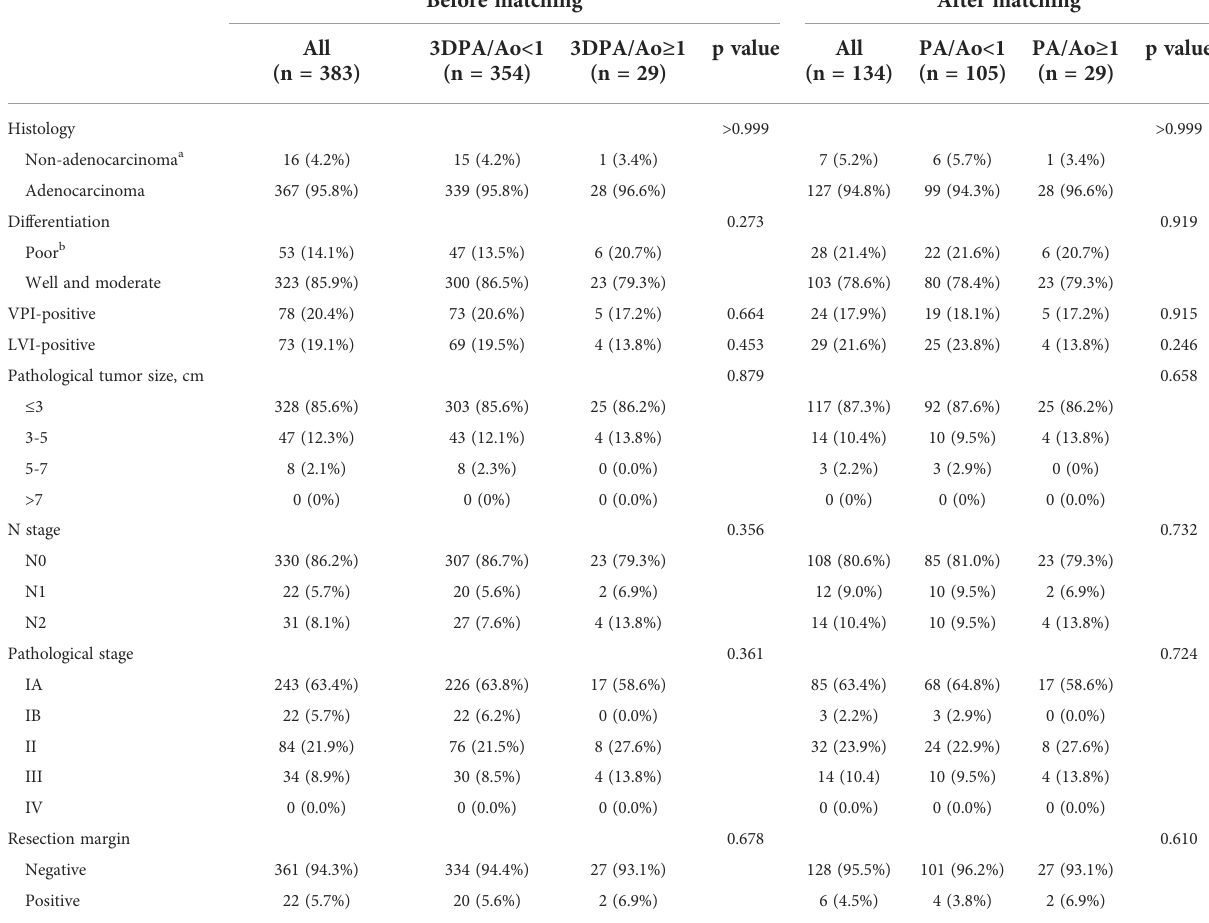
TABLE 2 Pathological features of the excised tumors of lung cancer patients undergoing lobectomy. Before